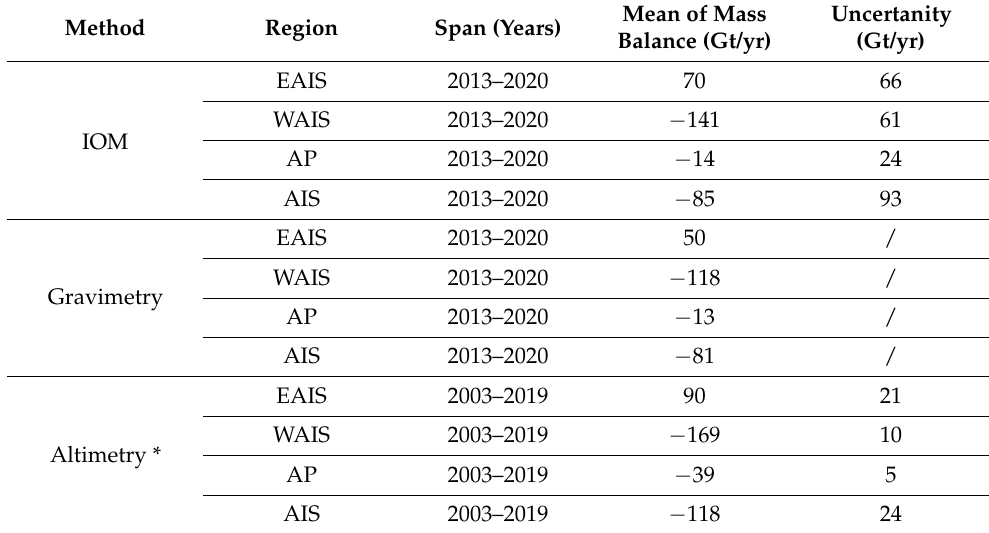
Table 4. Results of mass balance from our IOM-based estimate, the gravity-based method, and the altimetry-based